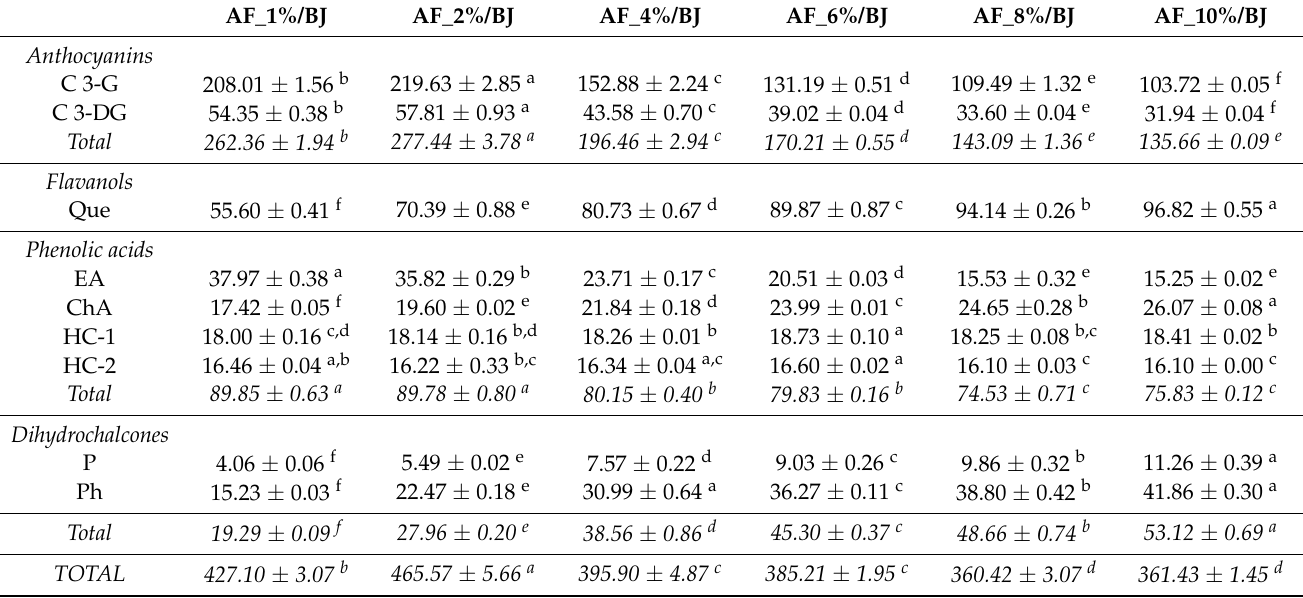
Table 3. Individual polyphenols content (mg/100 g) in apple fiber/blackberry juice